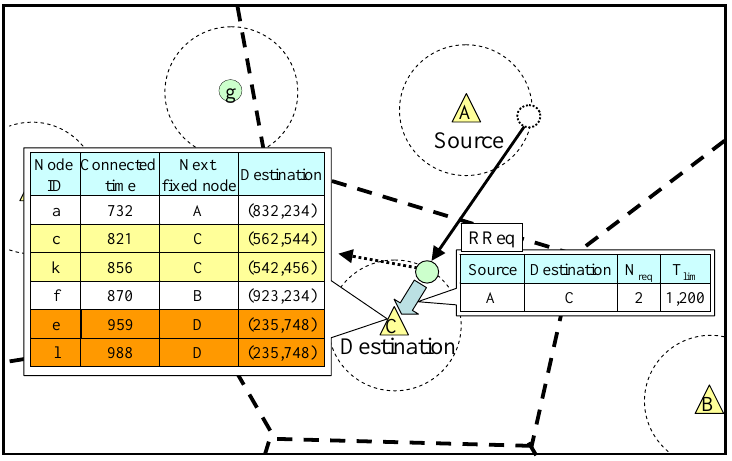
Figure 5. (b) Sending RReq to connected fixed node.